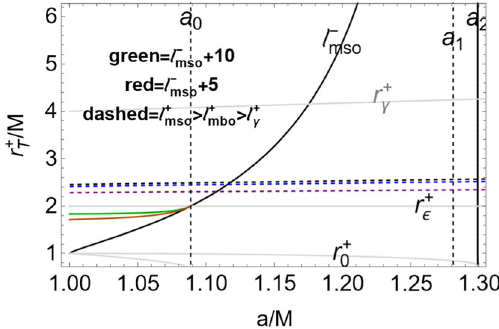
Fig. 17 Analysis of the inversion radius r + (cid:2) on the equatorial plane σ = 1, for fluids with specific angular momentum (cid:6) = (cid:6) + < 0 and (cid:6) = (cid:6) − (cid:8) 0 signed on the panel, as functions of the NS spin-mass ratios a / M . Spins { a 0 , a 1 , a 2 } are defined in Table 2. Notation ( mso ) is for marginally stable orbit, ( mbo ) is for marginally bounded orbit, (γ) is for marginally circular orbit. The most general solutions are shown not considering constraints of Sect.